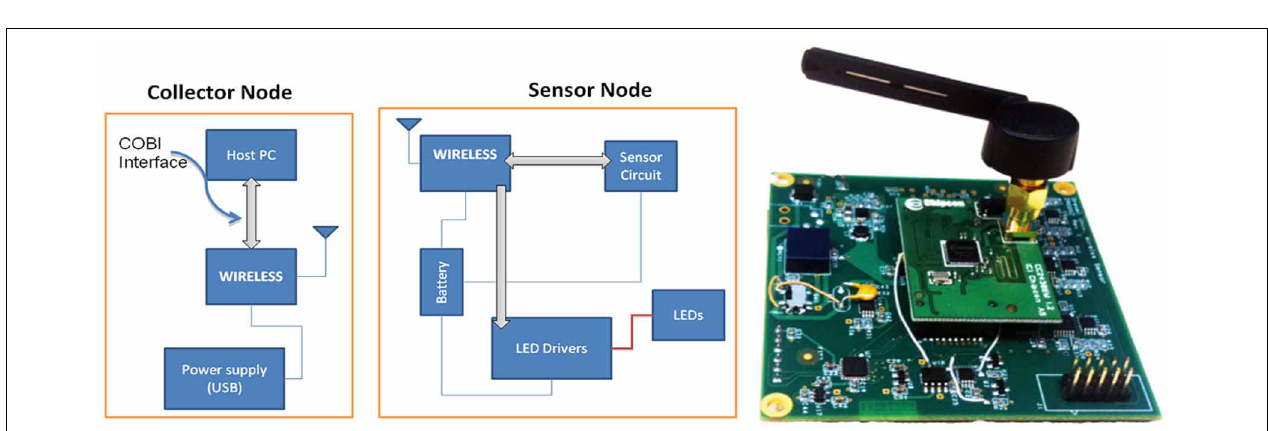
FIGURE 12 | Block diagram of the wireless fNIR controller box (left) and sensor node, circuit board implementation (right).